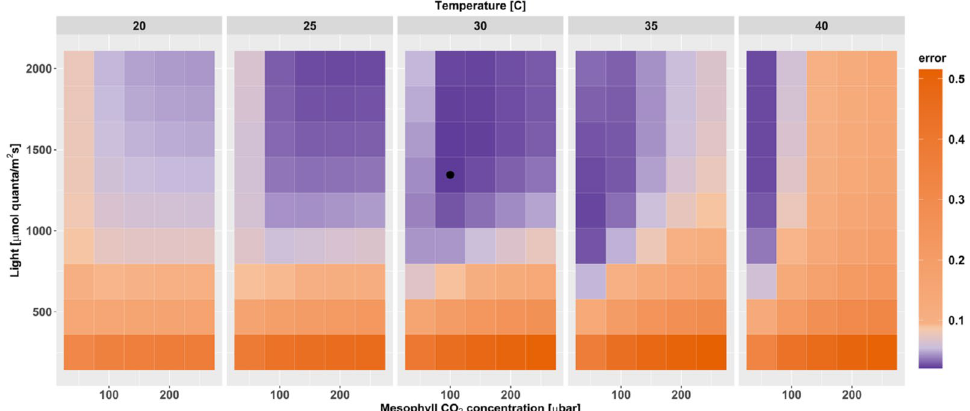
Figure 5. Discrepancy between measured and modeled F. bidentis data across diverse environments. The black circle indicates the environment that best explains the experimental data of Dwyer, et al. 56 . The deviation between model predictions and measurements (‘error’) is defined as the mean of the squared residuals (which are expressed as fractions of experimental means). Figure created using R 4.0 52